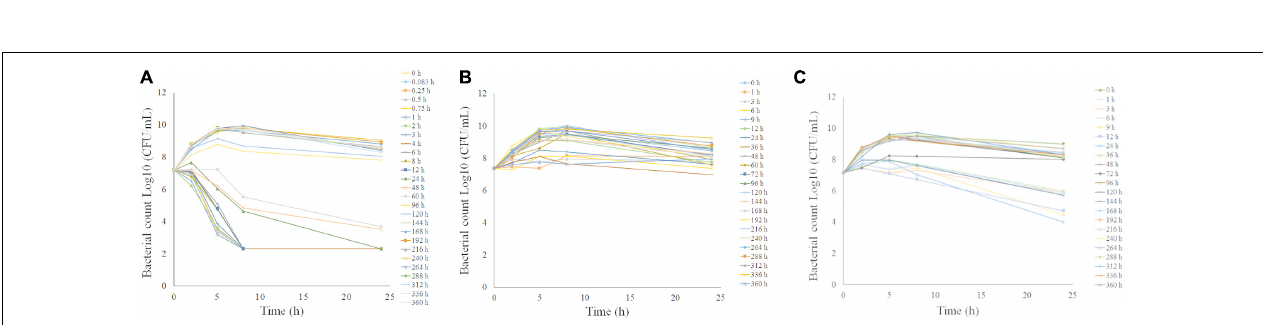
Frontiers in Pharmacology |